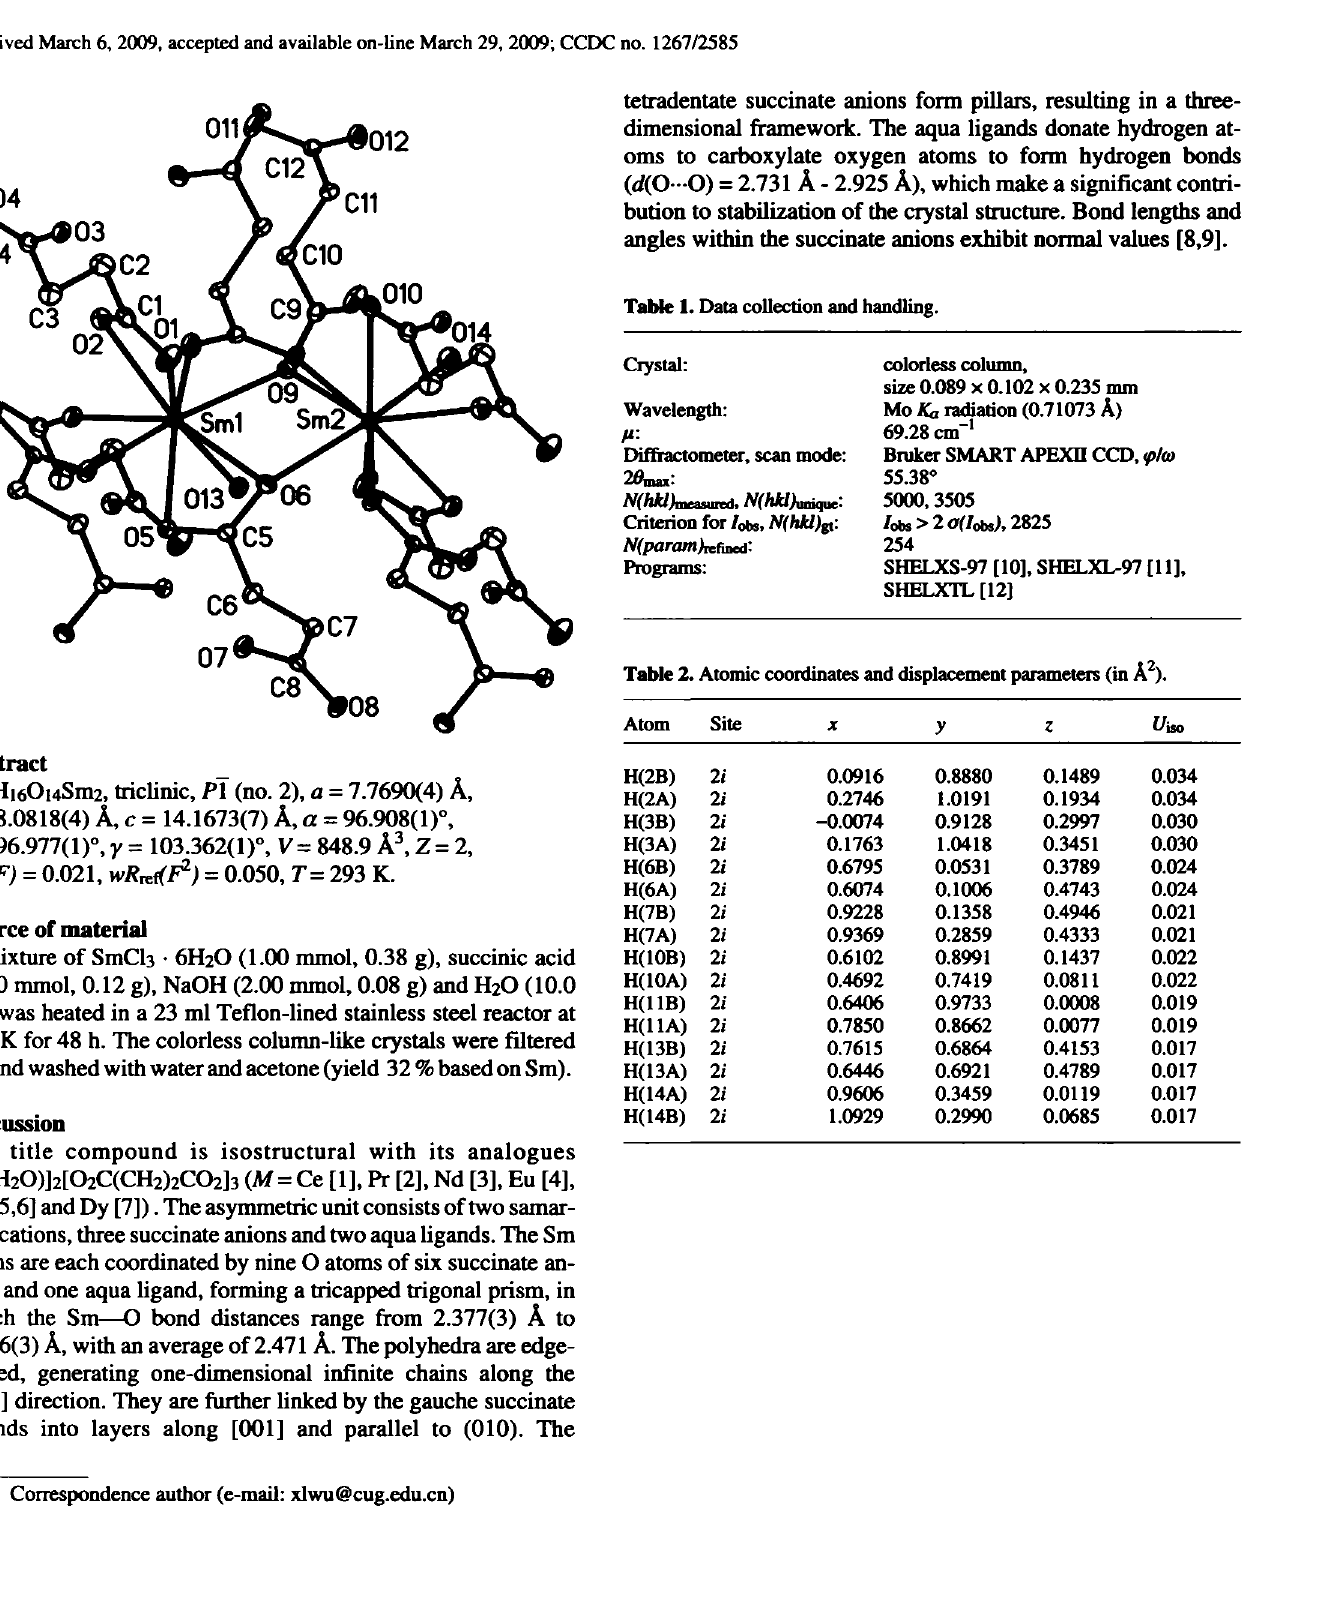
Table 1. Data collection and handling.